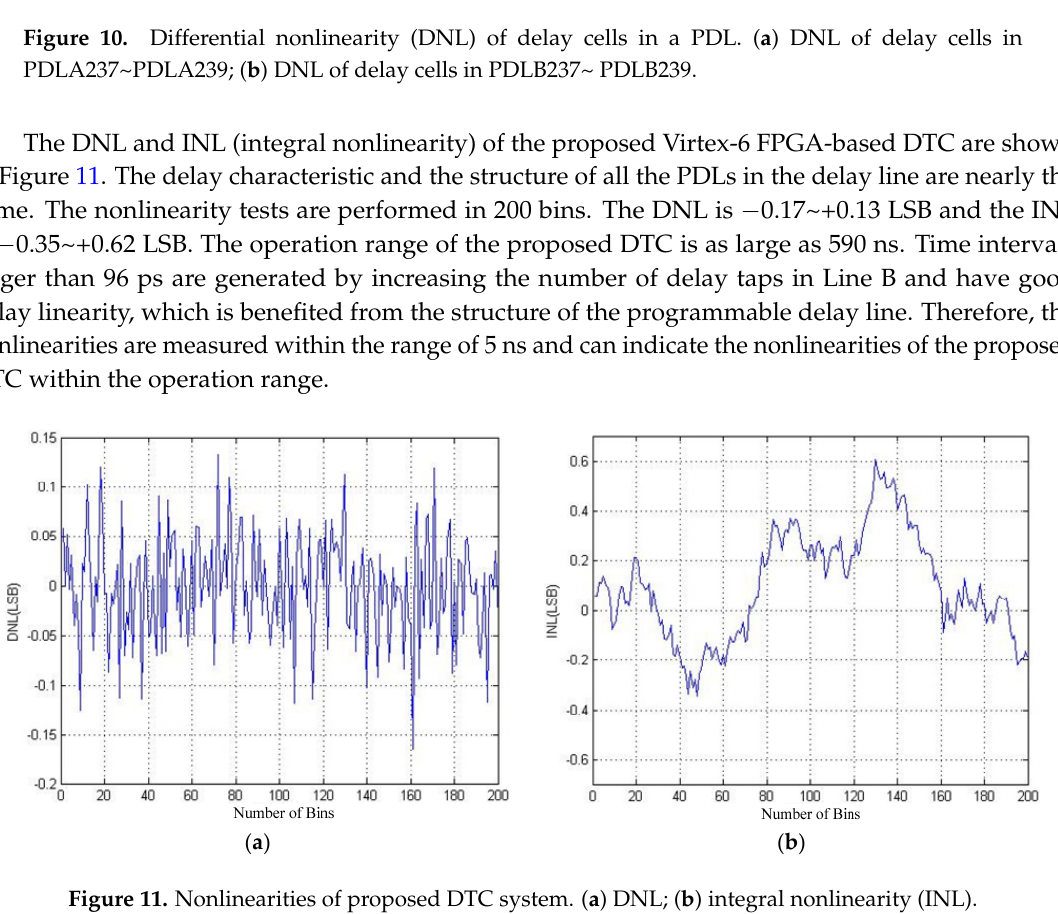
Figure 11. Nonlinearities of proposed DTC system. ( a ) DNL; ( b ) integral nonlinearity (INL).